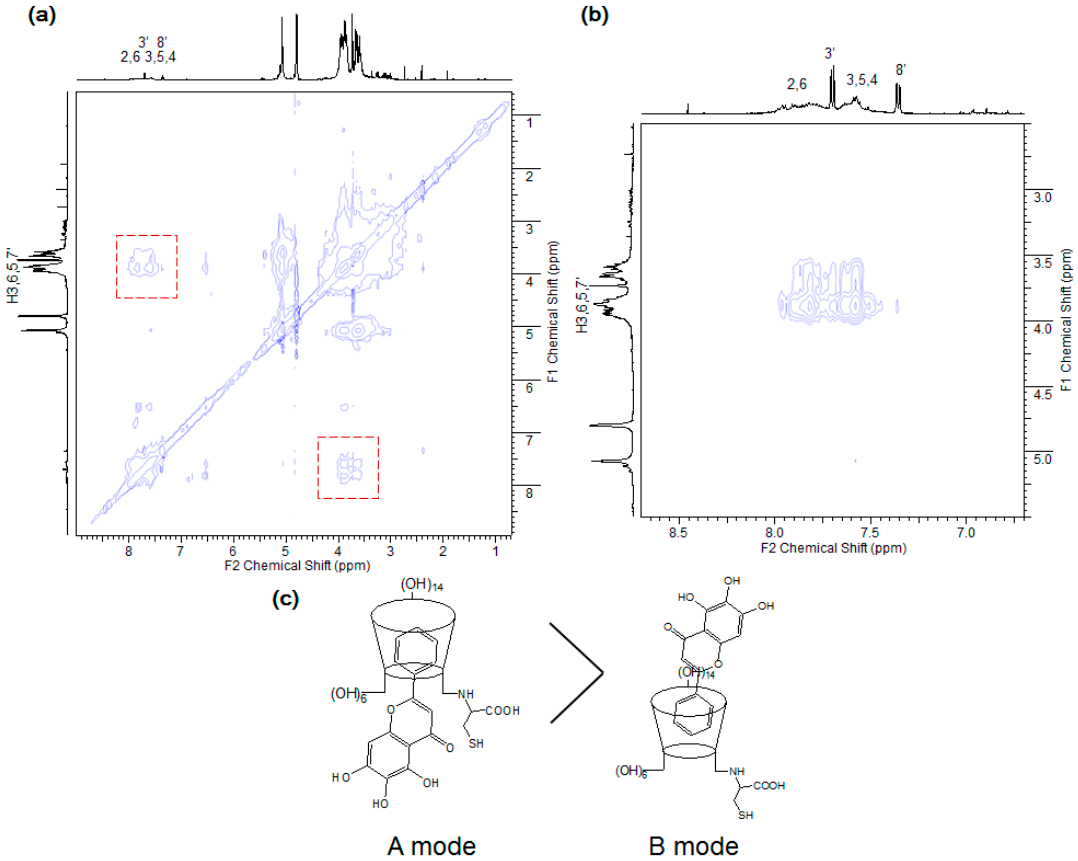
Figure 5. ( a ) NOESY spectrum of cysteinyl β -CD/baicalein complex (Solvent: D 2 O); ( b ) Enlarged spectrum of the area in the red rectangle; ( c ) The proposed model of the cysteinyl β -CD/baicalein complex.